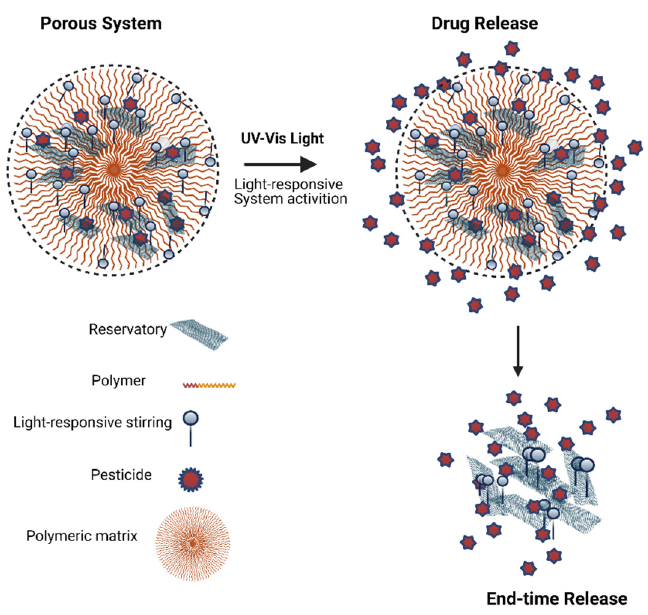
Figure 1. Schematic illustration of light-responsive system for modified pesticide release.